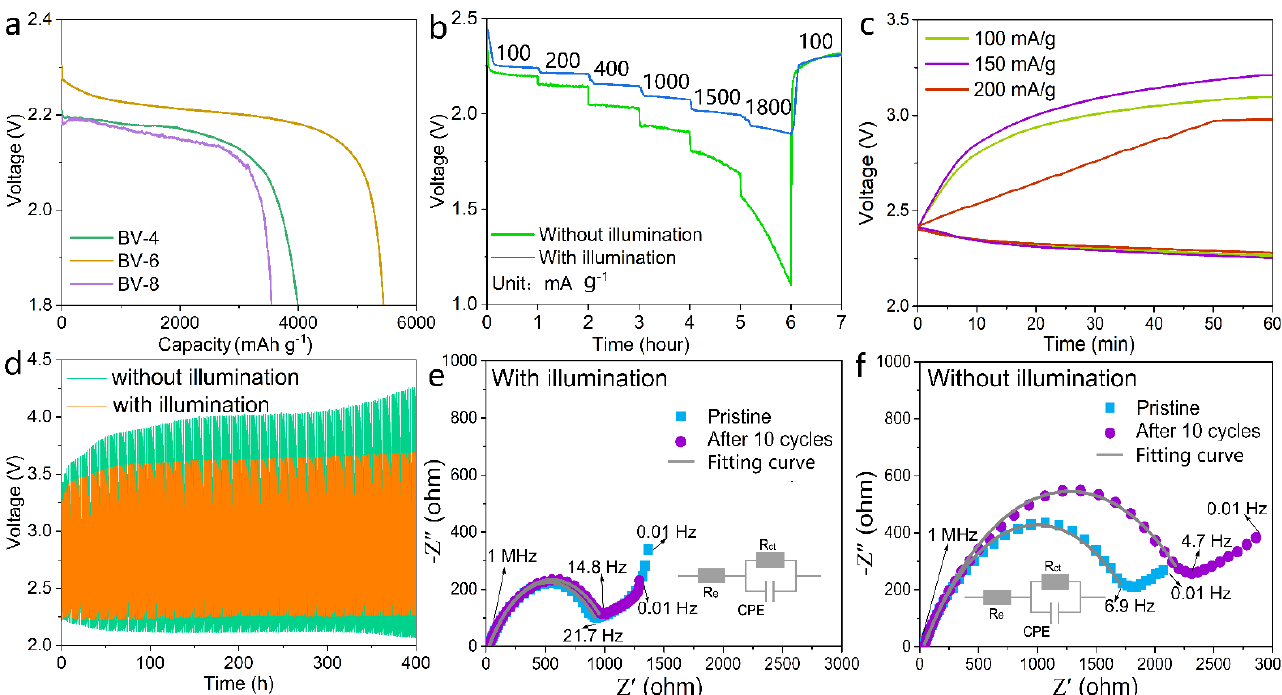
Figure 3. ( a ) The free-discharge curves, ( b ) the rate capability, ( c ) the discharge/charge curves at different current densities, ( d ) the cycling performance, and the EIS of the Na – O 2 batteries using BV – 6/CNTs cathode under ( e ) illumination, ( f ) no illumination.